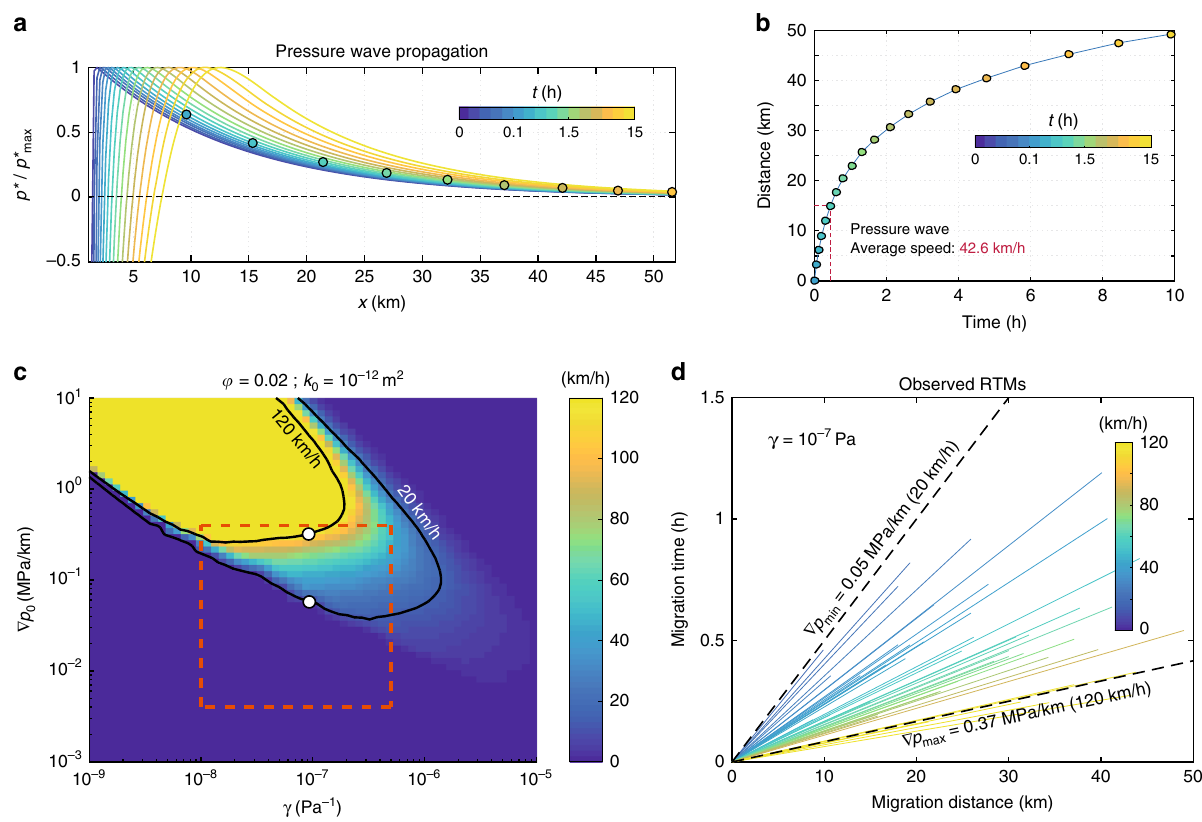
Fig. 1 Analysis of the non-linear diffusion equation under plausible conditions for the Guerrero subduction zone. a Pore-pressure wave propagation predicted by Eq. (2), where p * = p − p 0 . Circles show the position of the wave front for a pore-pressure threshold of 3 kPa and color shaded the time in hours. b Wave front propagation (circles in panel a ) and average speed after 15 km. c Parametric study of Eq. (2) in terms of wave speeds for a threshold of 3 kPa (see Supplementary Figure 3 for different permeabilities). Speed values between the black curves include those observed for RTMs in Guerrero. Red box delineates γ values observed in laboratory experiments 40 and the maximum pore-pressure gradient induced by the 2006 SSE (lower limit). d Guerrero RTM speeds bounded by the two theoretical limits indicated with white circles in panel